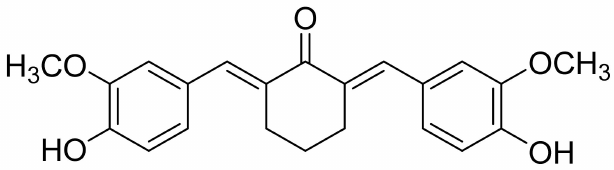
Figure 1. Structure of cyqualone (CL, 2,6-bis((3-methoxy-4-hydroxyphenyl) methylene)